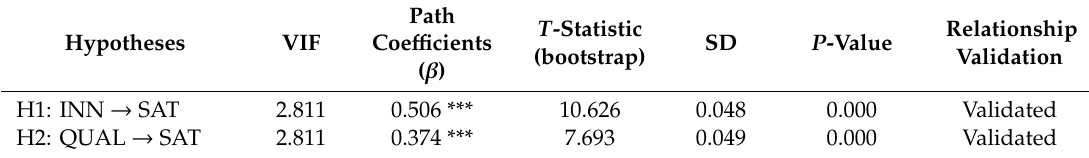
Table 8. Contrast of hypotheses, correlation coe ffi cients, and explained